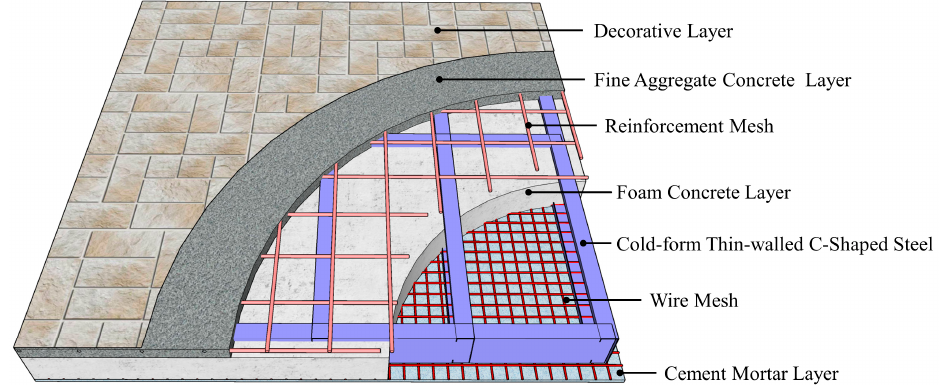
Figure 1. Diagram of the composite